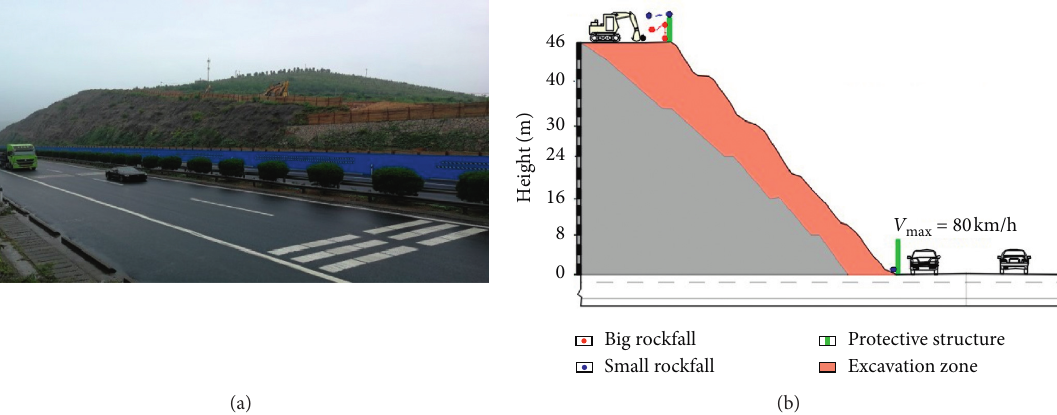
Figure 12: Highway road on the site during the construction: (a) observation highway road on the site and (b) schematic diagram of construction